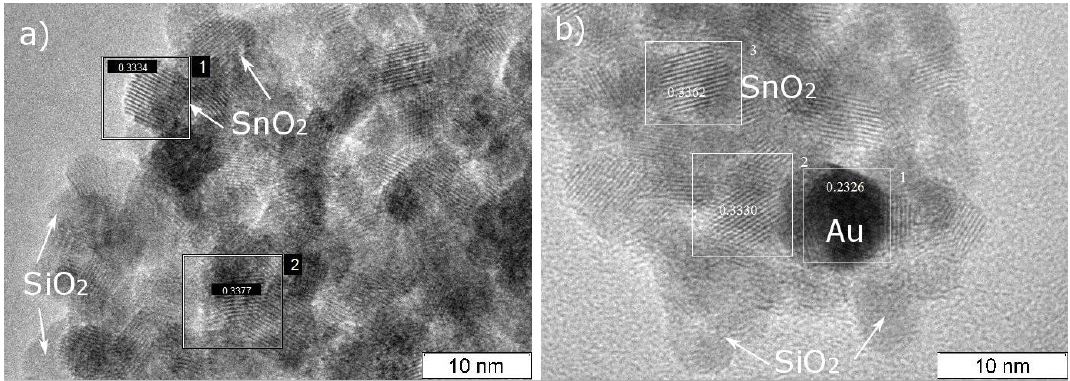
/ SiO / SiO 2 2 ; ( b ) SnO 2 2-